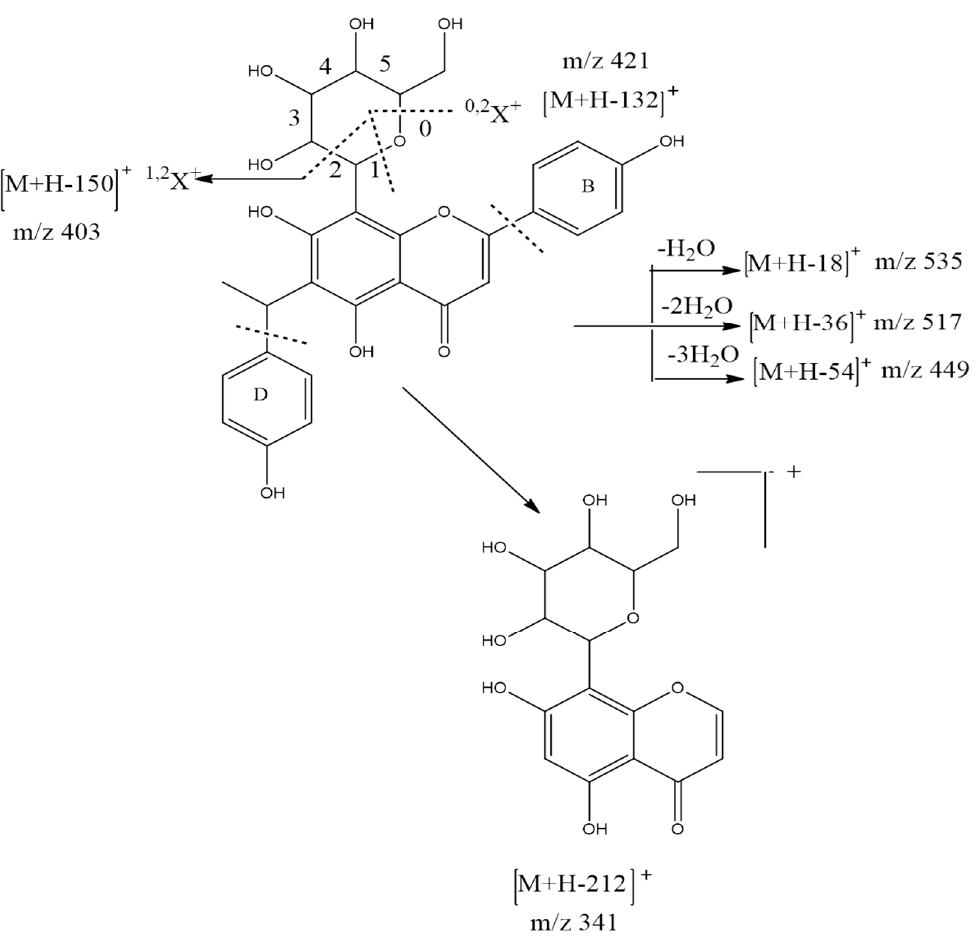
Figure 5. Fragmentation pattern of cucumerin A.